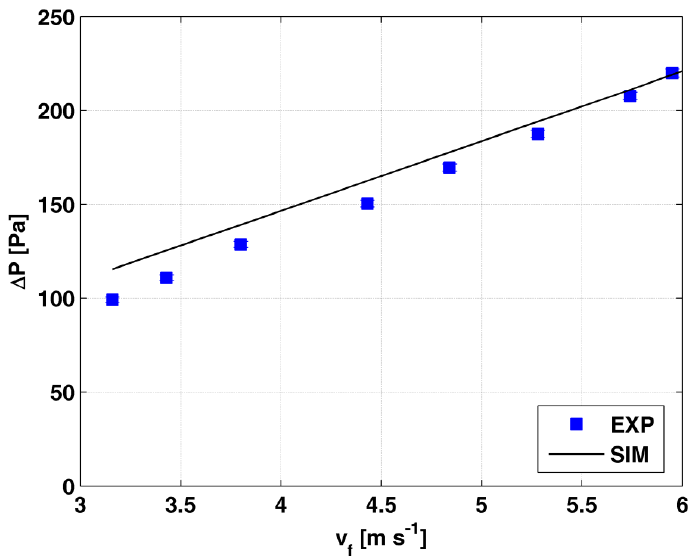
Figure 4. Pressure drop: experimental data and simulation results at T a = 25.0 °C, X a = 8.2 g kg −1 and φ a = 42%. Refer to Table 1 for heat wheel data.